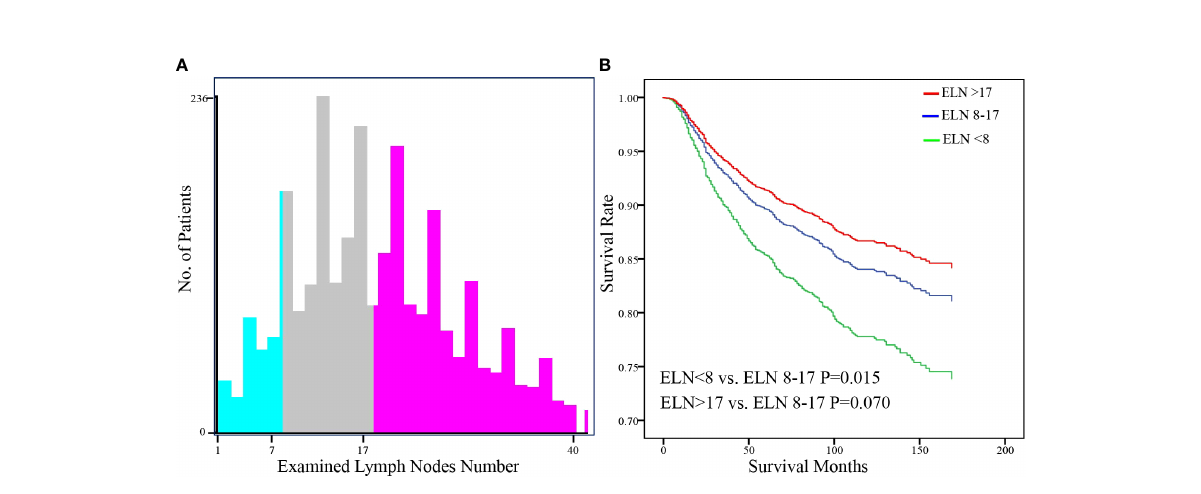
FIGURE 5 Identi fi cation of the optimal cut-off value of ELN for FIGO Stage IB-IIA Cervical Squamous Cell Carcinoma patients based on the x-tile software (A) . Strati fi cation of adjusted overall survival according to cutoff values (B) . Multivariable Cox regression was used adjusting for age, year of diagnosis, race, tumor location, tumor size, differentiation, FIGO stage, PLN number, resection type, administration of radiotherapy and chemotherapy, and marital